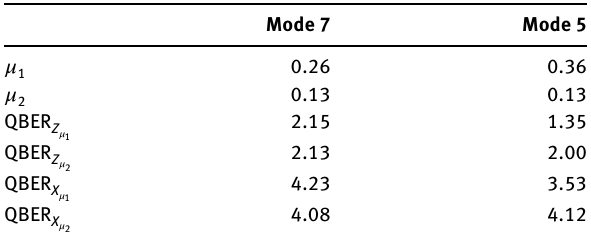
Table 1: Experimental mean photon numbers for the 2-mode multiplexing demonstration as well as QBERs and SKR attained for each